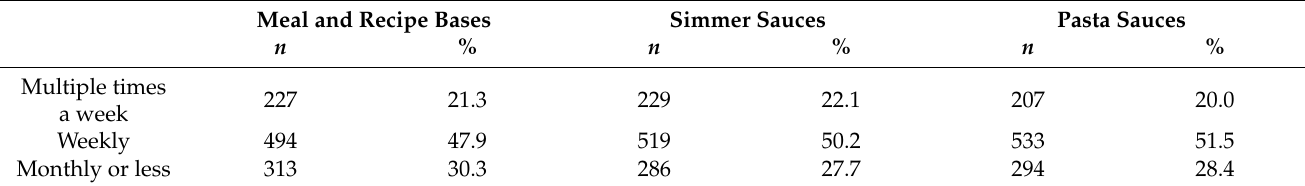
Table 2. Reported usage frequency of selected convenience cooking products.